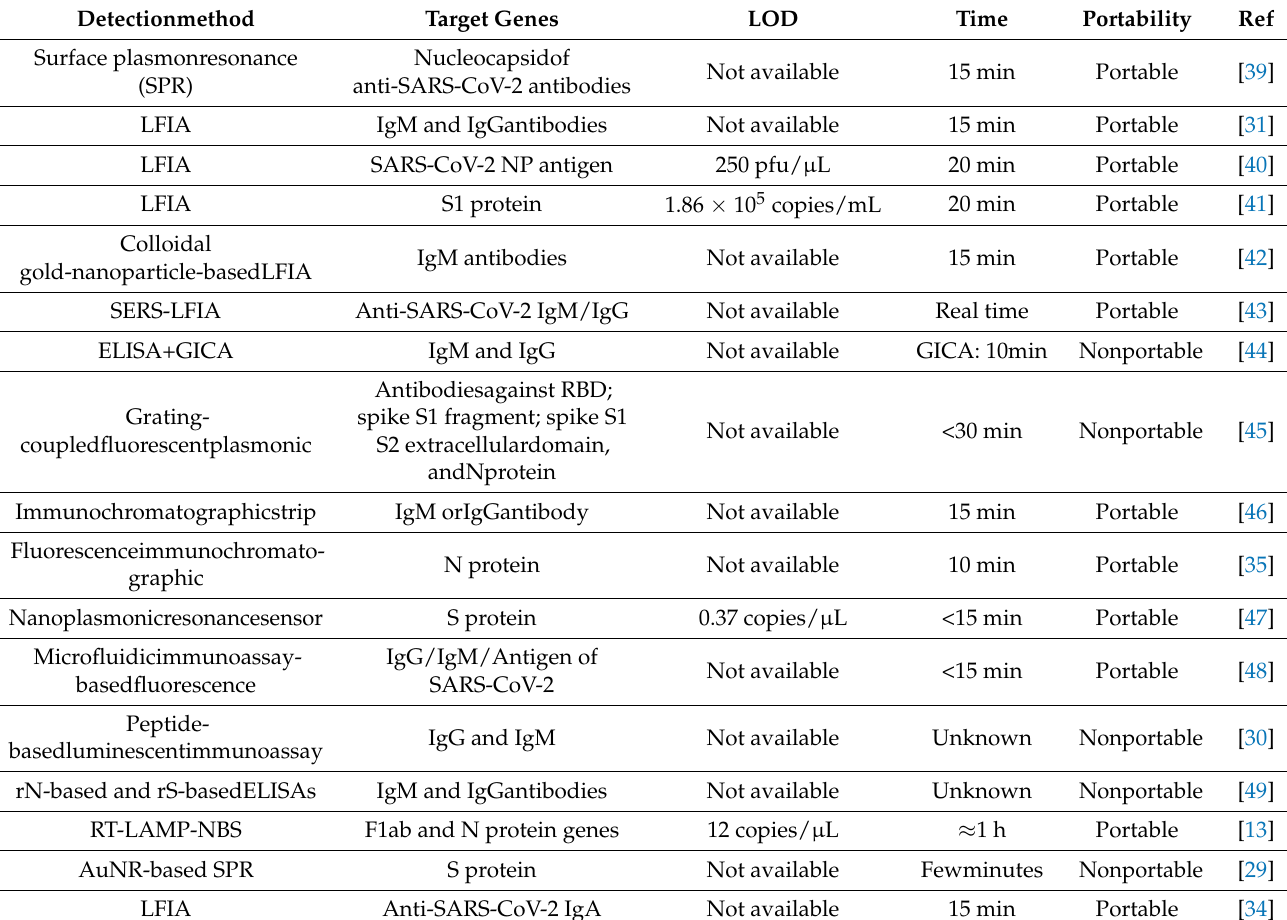
Table 2. Optical biosensors for SARS-CoV-2